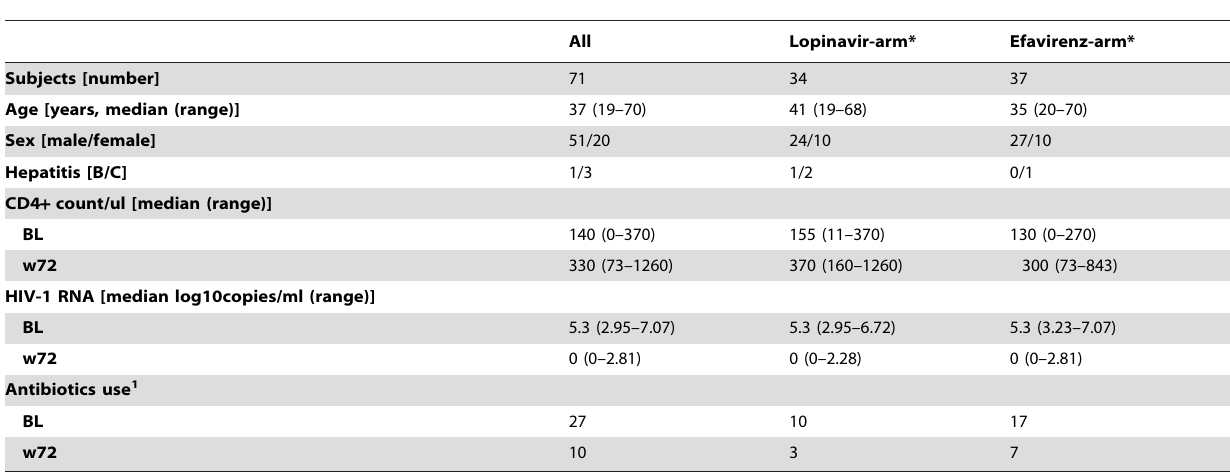
Table 2. Characteristics of HIV-1 infected patients.